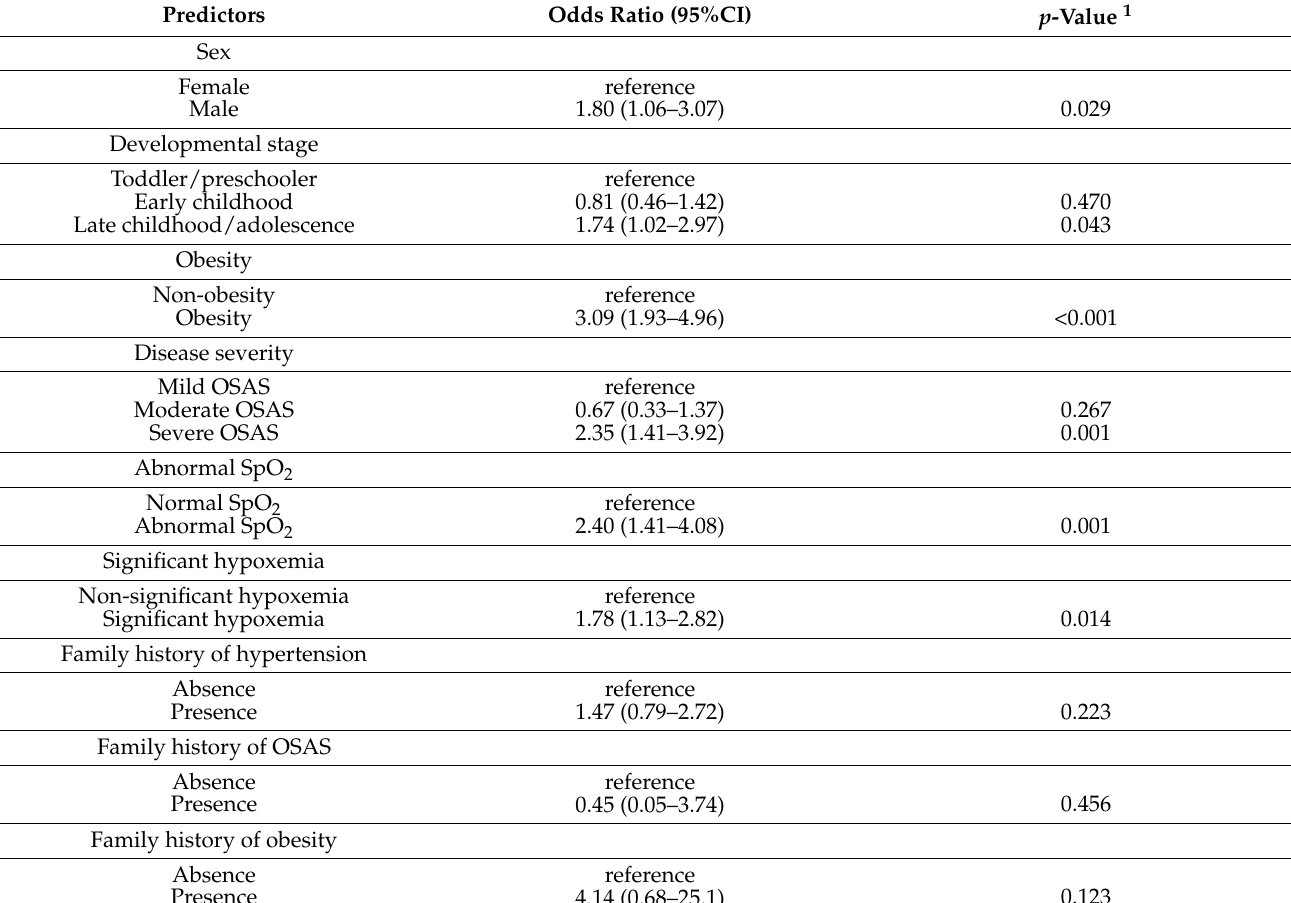
Table 3. Univariate logistic regression models for predicting pediatric hypertension in the overall